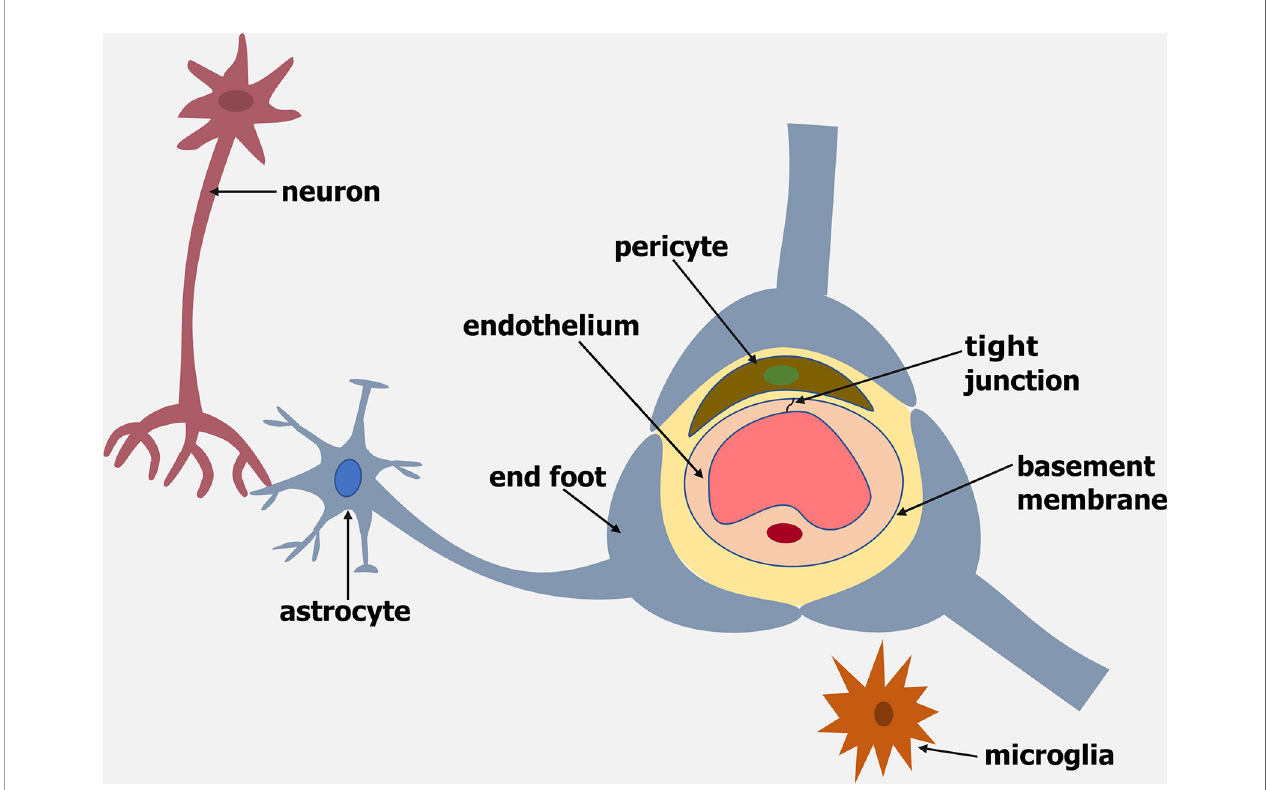
FIGURE 1 | Schematic representation of the Neurovascular Unit (NVU). The NVU is made up of an endothelium, basement membrane, pericytes, microglia, astrocytes and